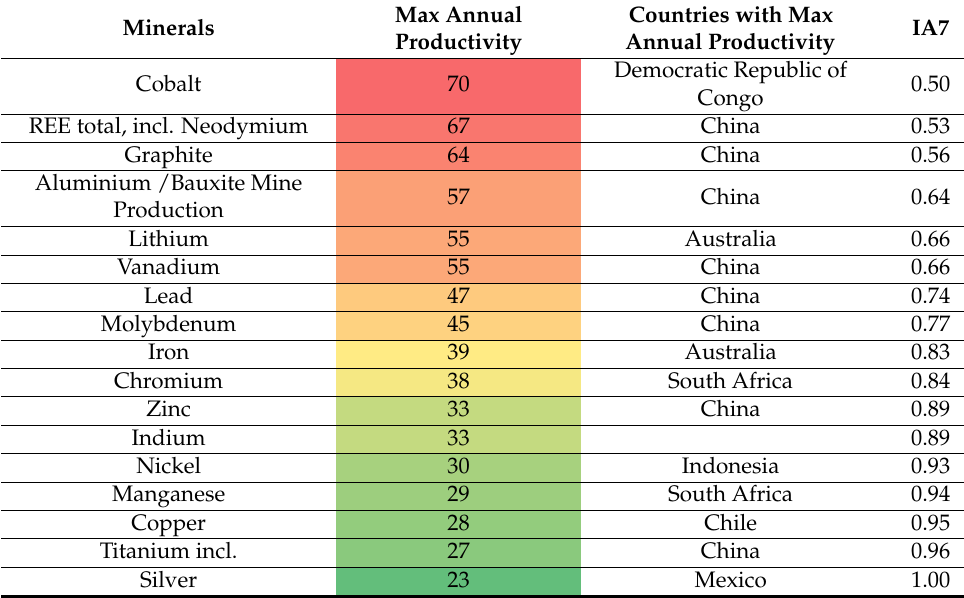
Table A7. Ranking of minerals for each country with max annual